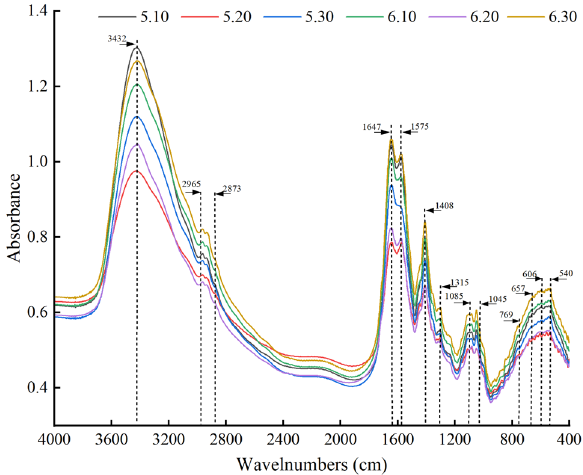
Figure 2. Fourier transform infrared spectroscopy (FTIR) functional group changes in earthworm mucus under different electrical stimuli. 5.10, 5.20, 5.30, 6.10, 6.20, 6.30 indicate 5 V 10 mA, 5 V 20 mA, 5 V 30 mA, 6 V 10 mA, 6 V 20 mA, and 6 V 30 mA, respectively.